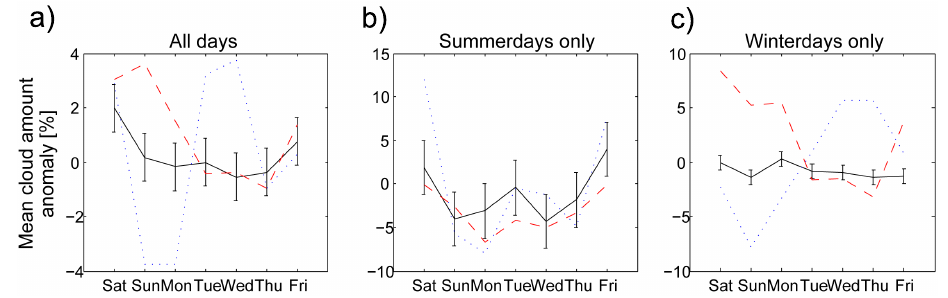
Fig. 10. Weekly cycles of regional mean (average of the 30 stations in the Black Triangle) cloud amount anomaly, for the entire 1983–2008 period (solid black line), the more polluted 1983–1987 period (red dashed line) and the cleaner 2004–2008 period (blue dotted line) for (a) all days, (b) summer days and (c) winter days. Vertical bars show ± 1 standard deviation for the total